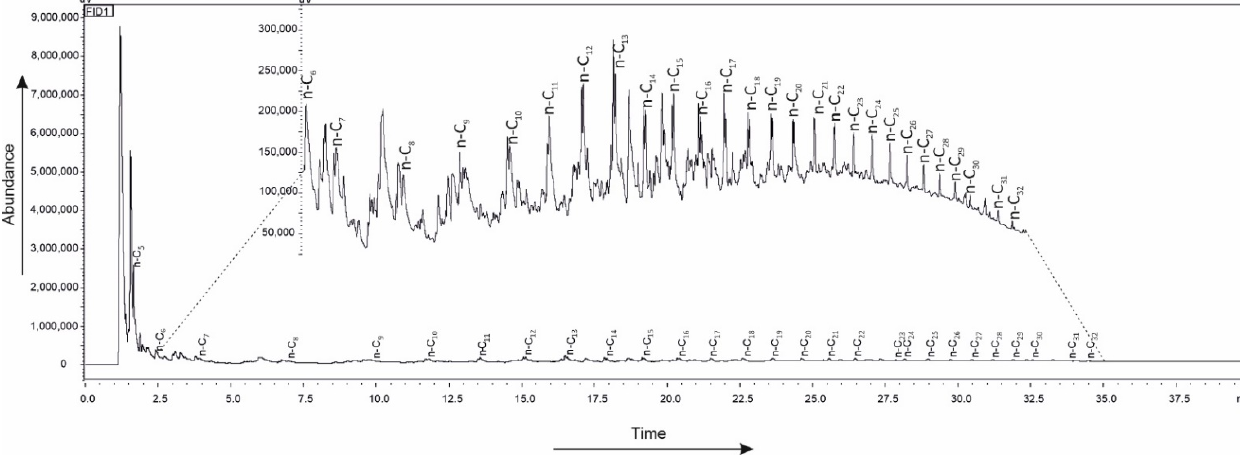
Figure 17. Distribution of hydrocarbon fractions generated through Py/GC at 300–650 °C, using the example of Sample 5